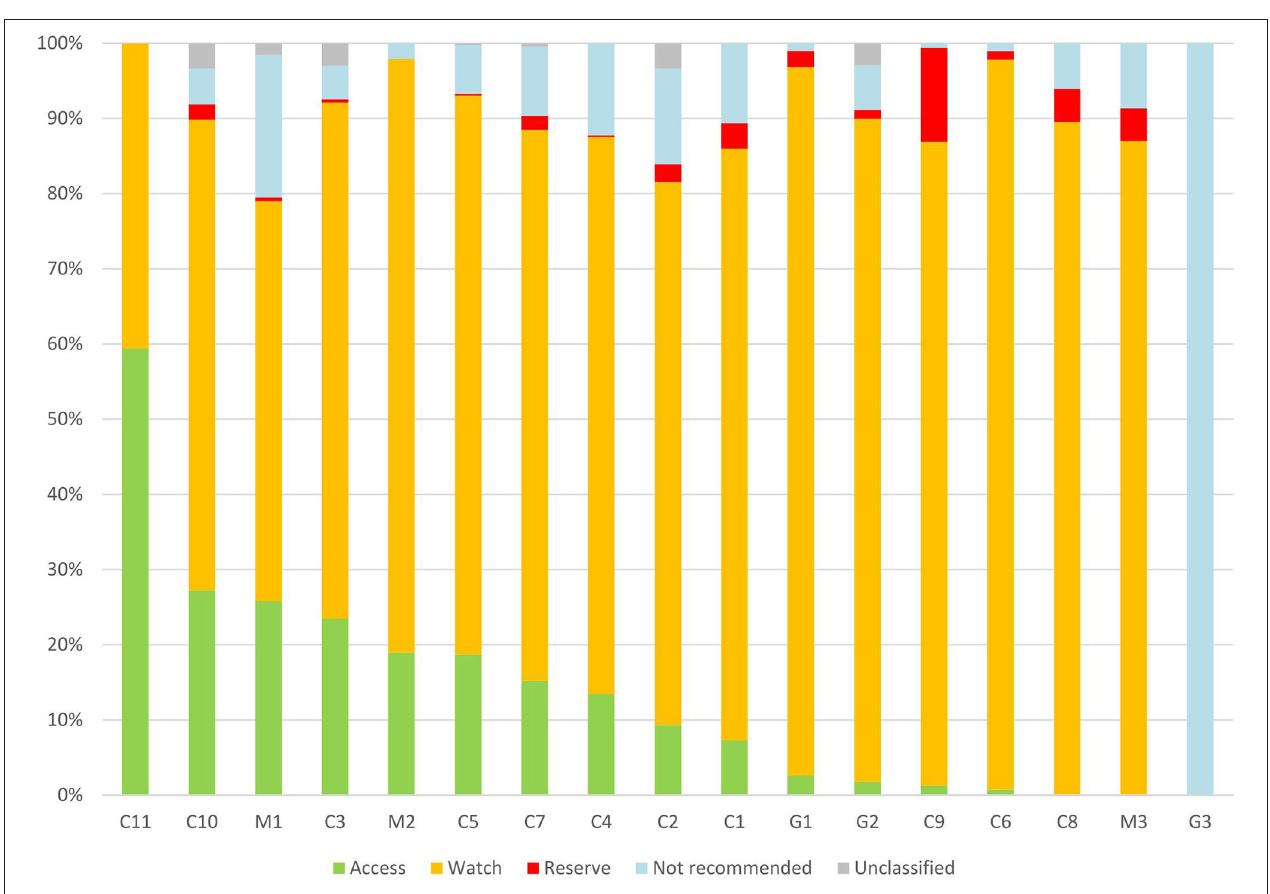
FIGURE 3 | Patterns of Access, Watch, Reserve antibiotics prescribed for children from different hospitals in China. C, children’s hospital; M, maternal and children’s; and G, general hospital.